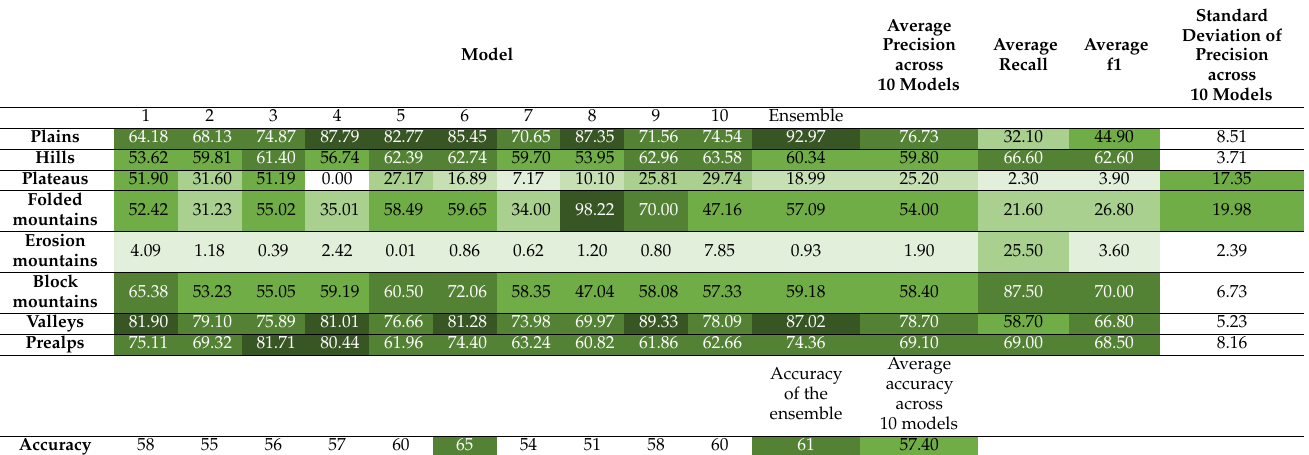
Table 3. Evaluation metrics across the 10 models and the ensemble (%). The darker the background of a cell, the higher the value it represents.